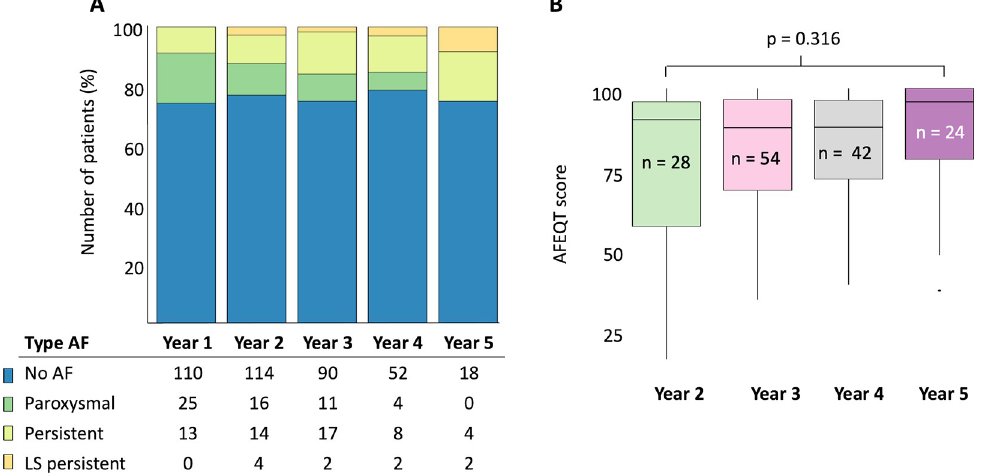
Fig 4. Type of atrial fibrillation per year of follow-up. A. The type of atrial fibrillation (AF) reported for each follow-up year per patient. B. Overall AFEQT score per year. Of note, figure does not display repeated measurements.